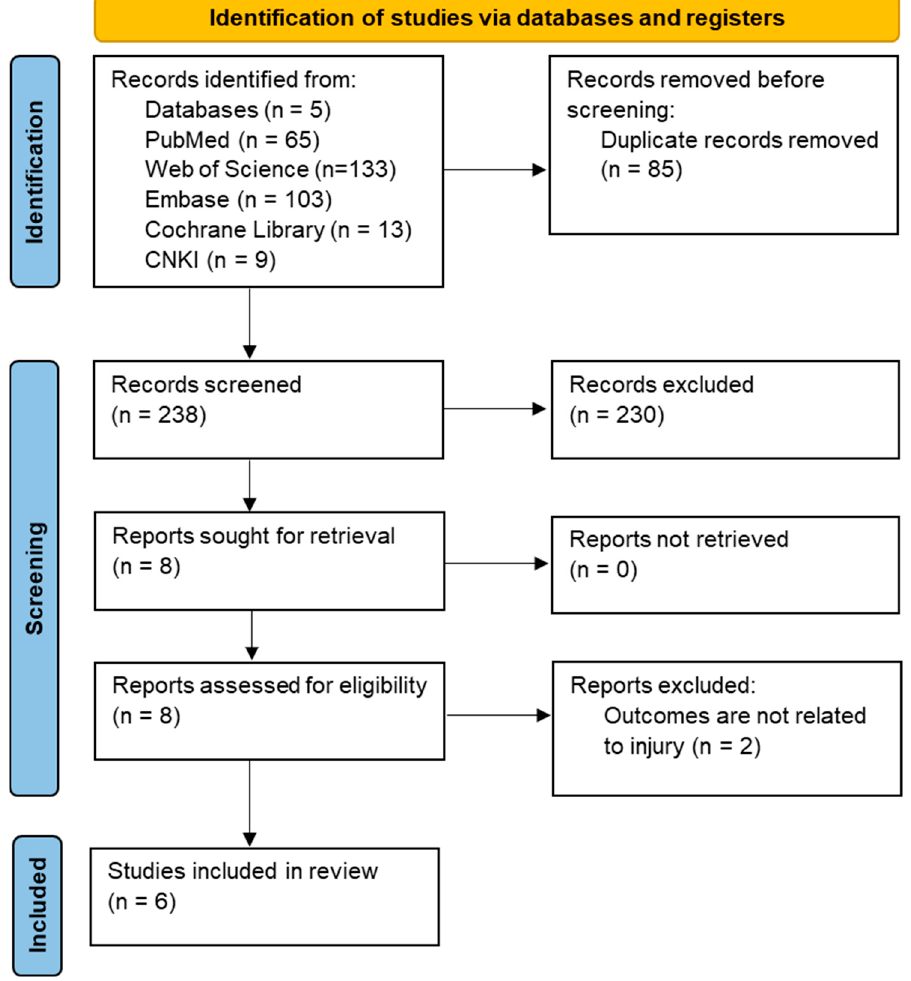
Figure 1. Screening process for systematic review in accordance with